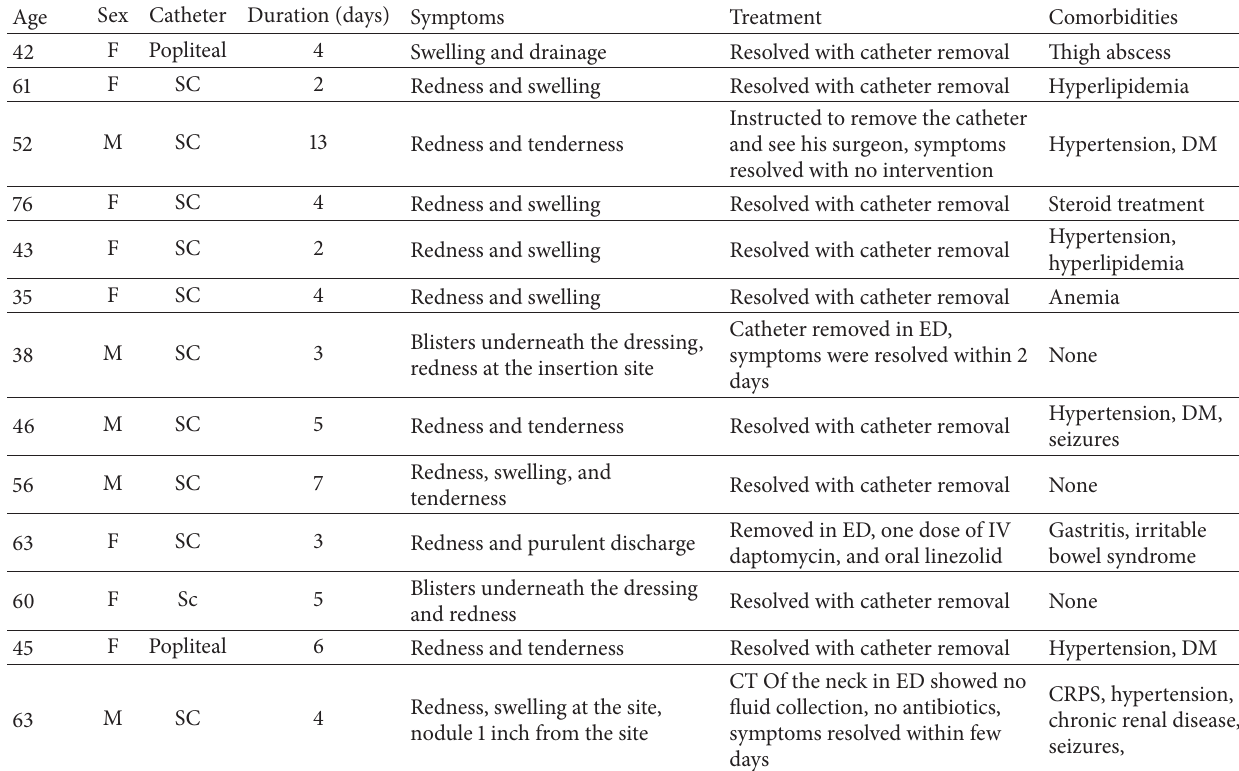
Table 2: Infectious